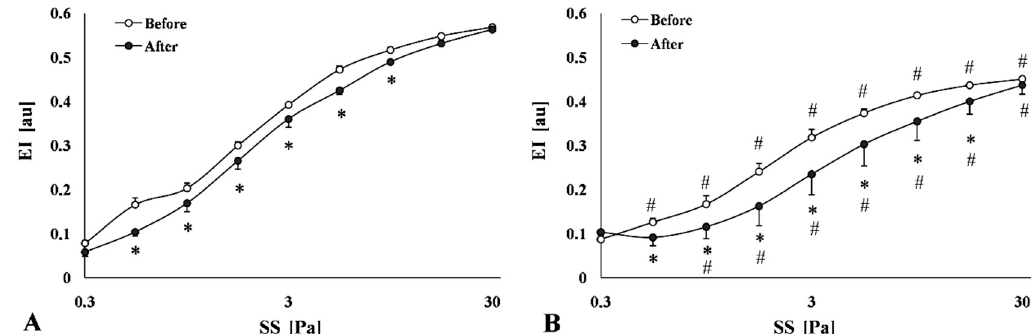
Figure 5. Elongation index (EI [au])—shear stress (SS [Pa]) curves in the mechanical stability test: before and after applying mechanical stress (100 Pa for 300 s) on the samples of the Control ( A ) and the atherogenic (HC) group ( B ). Means ± SEM; * p < 0.05 vs. before mechanical stress; # p < 0.05 vs. Control. Table 3. Comparative parameters of red blood cell membrane stability test before and after applying the mechanical stress (100 Pa for 300 s). EI at 3 Pa: elongation index at shear stress of 3 Pa, EI max